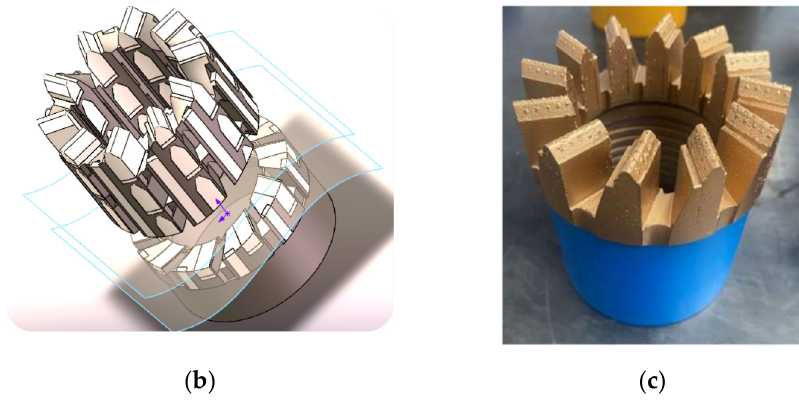
Figure 6. Schematic diagram of diamond drill bit. ( a ) Side view and top view of diamond core bit; ( b ) 3D-schematic diagram of diamond core bit (scale: 1:4); ( c ) The solid body drawings of diamond core bit.